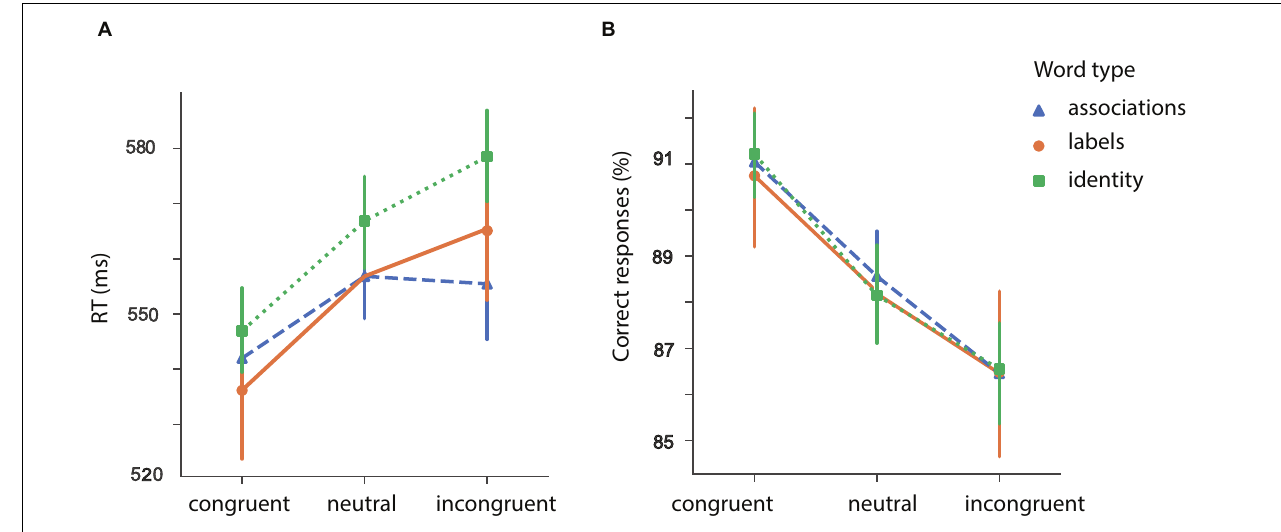
FIGURE 5 | Mean reaction times (A) and correct responses (B) for identity (“man”/“woman”) and associations [mix or associations (“beard”/“skirt”) and labels (“father”/“daughter”) as a function of semantic relatedness]. Error bars represent 95% confidence interval (CI); RT, response time.